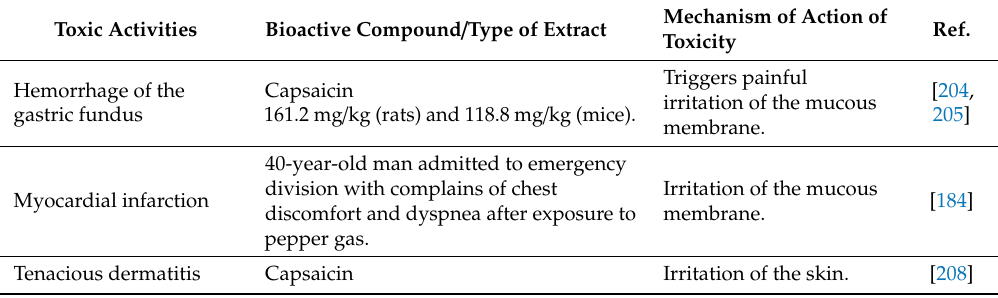
Table 7. Toxic e ff ects of Capsicum